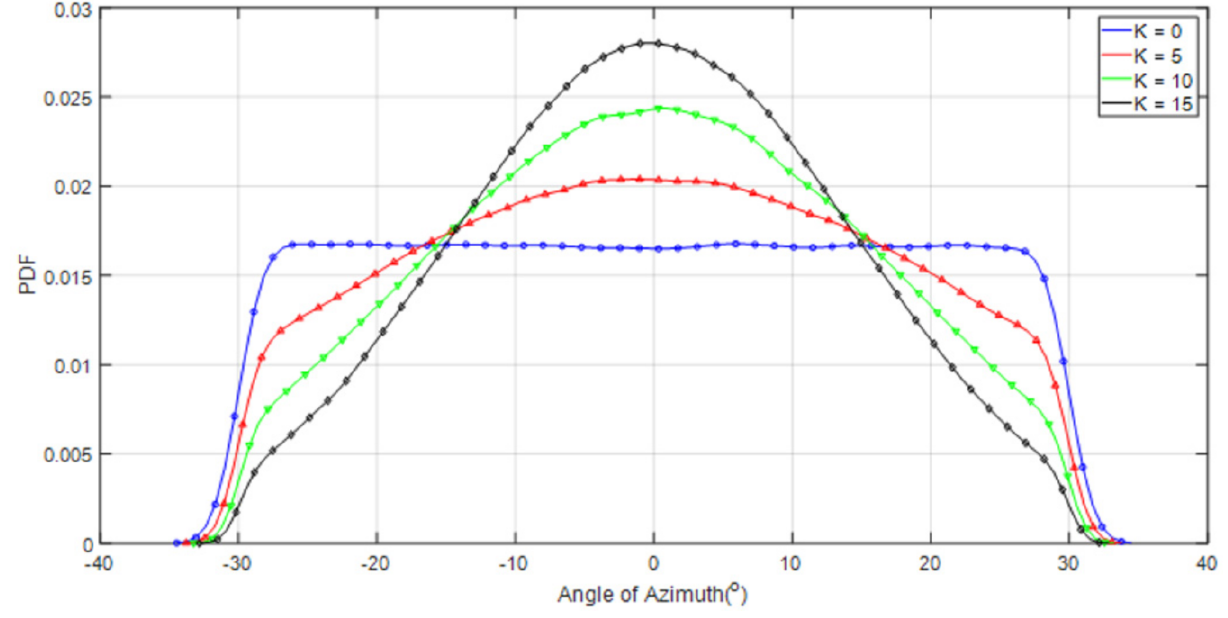
Figure 4. Probability density function of path